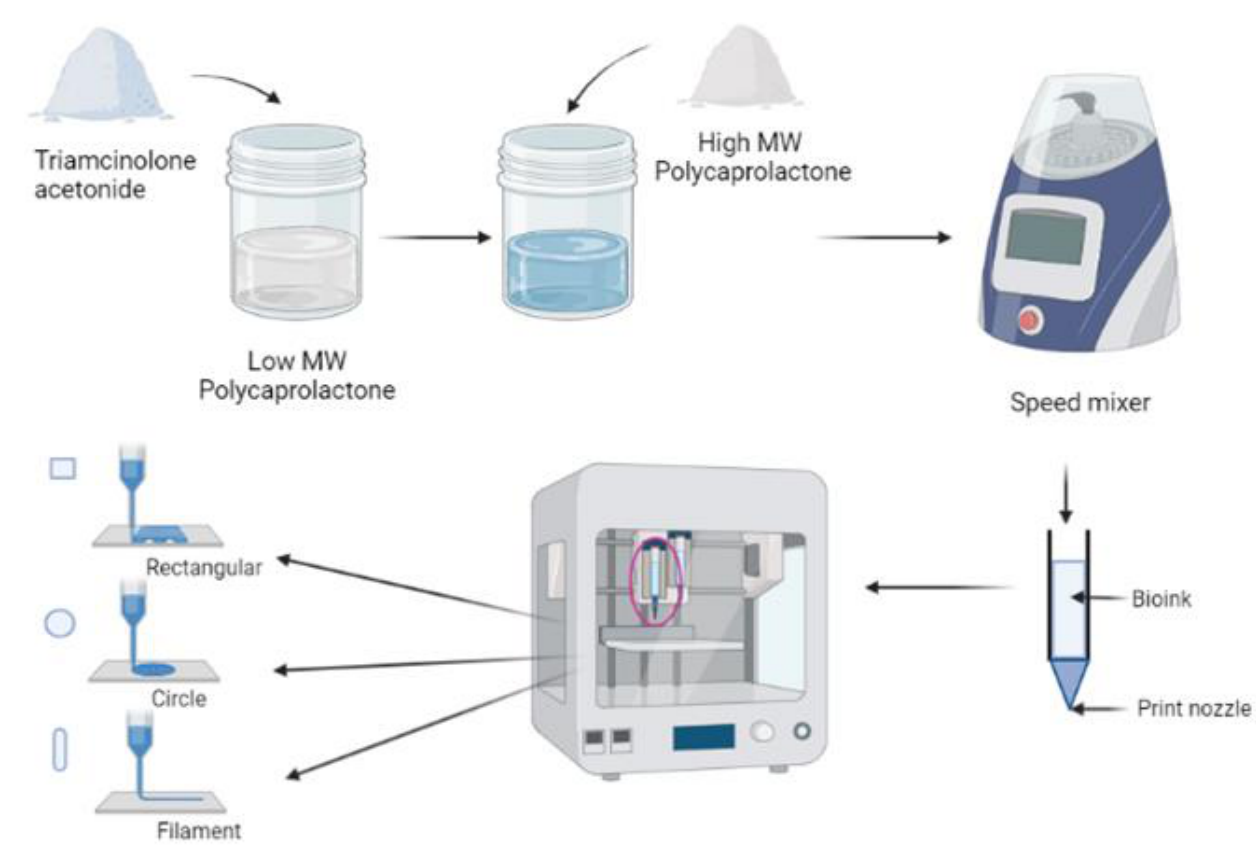
Figure 1. Schematic diagram of TA-loaded PCL implants fabrication using GeSiM 2.1 Bioscaffolder 3D Bioprinter.